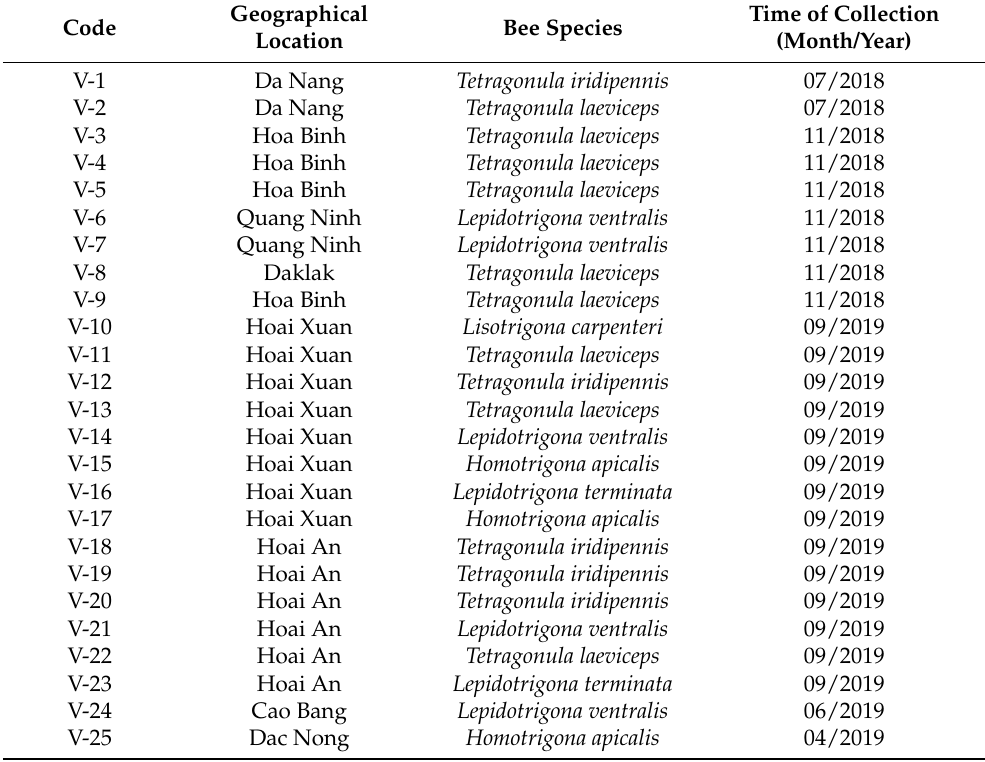
Time of Bee Species